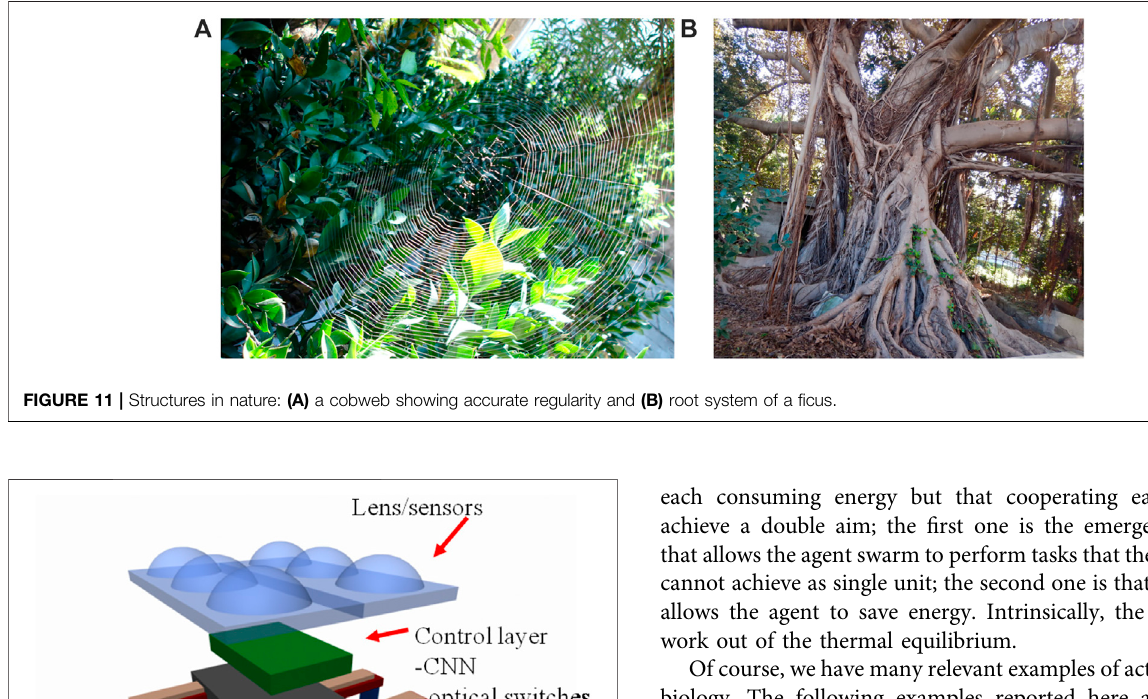
Frontiers in Physics |